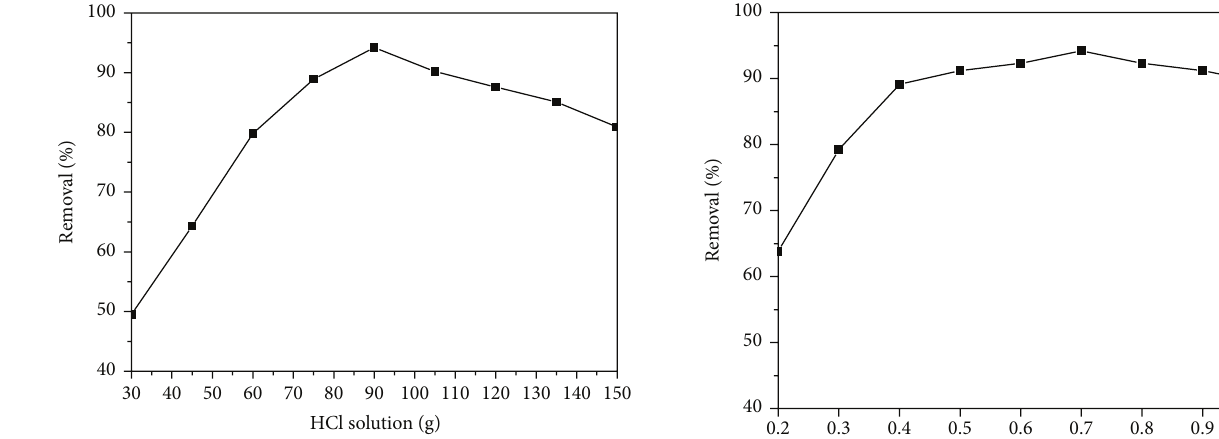
Figure 5: Effect of amount of HCl solution on the removal percent- age of MO. Experimental conditions: 30 g red mud, HCl 5 mol/L, 5 × 10 −5 mol/L MO, 0.7 g/L modified red mud, and irradiation time of 50 min.